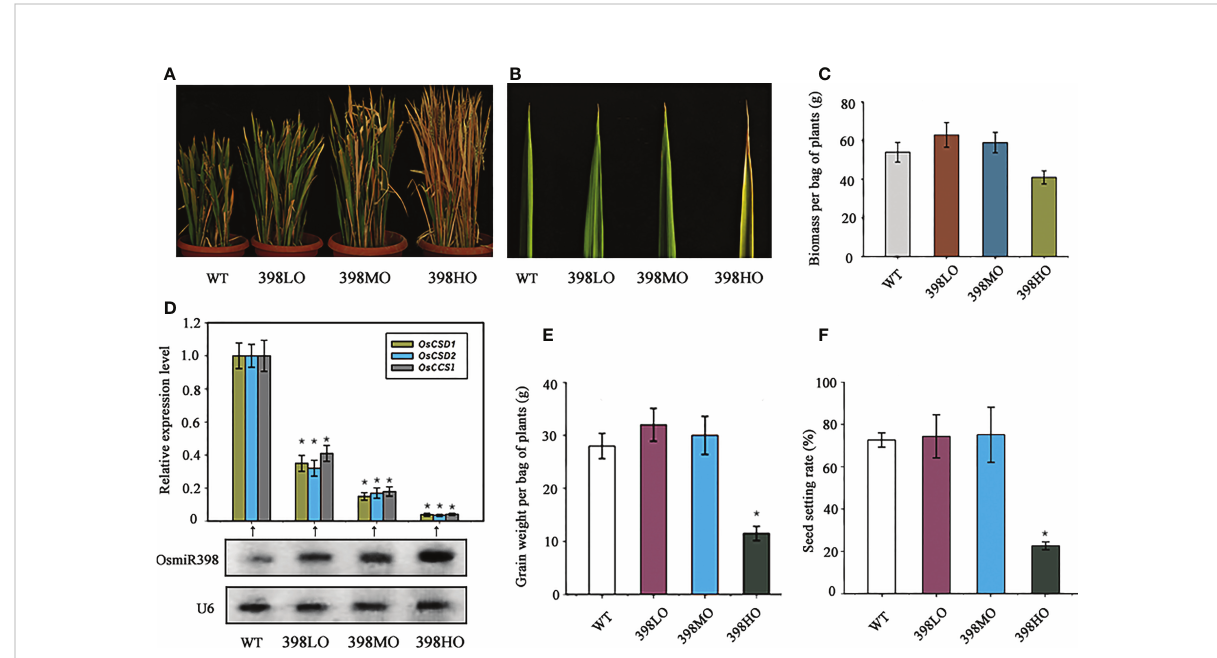
FIGURE 1 The agronomic performances of different levels of over-expressions of miR398 in rice under normal conditions. (A) . Morphologies of the WT (wild-type), 398LO (miR398 low level of over-expression), 398MO (miR398 moderate level of over-expression), and 398HO (miR398 high level of over-expression) at the mature stage. (B) . Phenotypes of the upmost leaf of the WT, 398LO, 398MO, and 398HO lines at the elongating stage (90d-old). (C) . Biomass (dry weight except grains) per bag of plants of the WT, 398LO, 398MO, and 398HO at the mature stage. (D) . Relative expression level of miR398 and its three targets in the WT, 398LO, 398MO, and 398HO lines. Targets were measured by Quantitative Reverse Transcription-PCR (qRT-PCR) and miR398 was detected by northern blot. U6 served as loading control. (E) . Grain weight per bag of plants of the WT, 398LO, 398MO, and 398HO after harvest. (F) . Seed setting rates of the WT, 398LO, 398MO, and 398HO lines at the mature stage. Asterisks indicate signi fi cant difference at P ≤ 0.05 compared with the wild-type by Student ’ s t test (n = 3; means ±